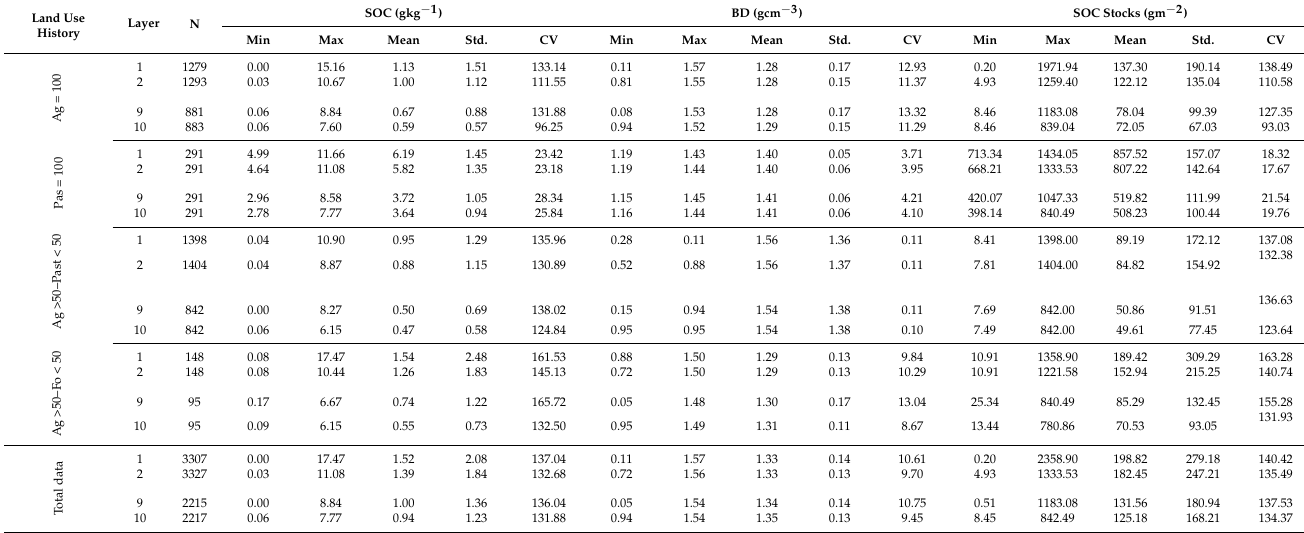
Table 3. Descriptive statistics of SOC, soil bulk density (BD) and SOC stocks in each layer based on LULC history.